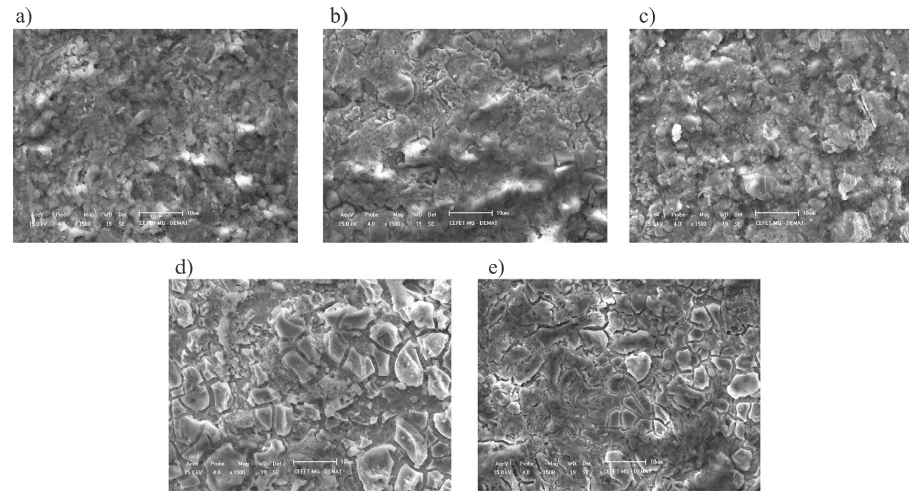
Figure 3. Samples coated with Ni/NiO. J1 (a), J2 (b), J3 (c), J4 (d) and J5 (3).